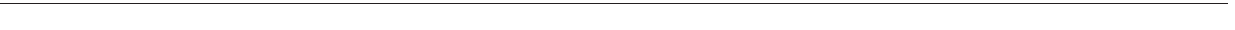
FIGURE 2 | Prediction error fi ring during delusion formation, maintenance and resolution. (A) Aberrant prediction error promotes delusion formation – Aberrant, internally generated prediction error signals imbue mere coincidences (the colors of doors and the sides of the street) with signifi cance which demands explanation (Chadwick, 2001). When an explanation is arrived at, the insight relief may engender dopamine fi ring which further stamps in the association between the odd experiences and the Organization (Miller, 1993). (B) Aberrant prediction error promotes delusion maintenance – Once the explanatory scheme has been developed, it is invoked any time an aberrant prediction error occurs. These reminders, serve to reconsolidate the belief that odd experiences are a result of the malevolent intervention of The Organization. This reconsolidation overcomes any extinction learning that may occur when no harm comes to the sufferer from The Organization or when others try to convince the sufferer that The Organization is not ministrating against them. (C) Medications target aberrant prediction error – Antipsychotic medications target aberrant prediction error signals, reminders do not occur and as such reconsolidation is blocked. New extinction learning is allowed to prevail and the individual recovers from their delusion. The mechanism for this targeting of prediction error induced reconsolidation may be at the level of neurotransmission in the synapse (e.g., Aripiprazole blocking phasic dopamine signaling (Hamamura et al., 2007) or it may be intracellular, targeting the way in which the experience-explanation belief is stored epigenetically (Bredy and Barad, 2008). (D) Aberrant prediction error promotes delusion maintenance – Prediction errors modulate the representations that govern behavior. Under aberrant prediction error, beliefs reconsolidate rather than extinguish. (E) Medication permits extinction learning by blocking aberrant prediction error – Under antipsychotic medication, aberrant prediction errors are blocked, allowing extinction learning to dominate and the resolution of the delusional